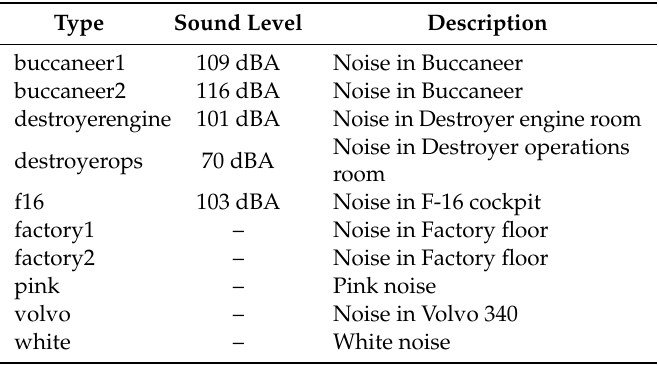
Table 3. Information of Dataset